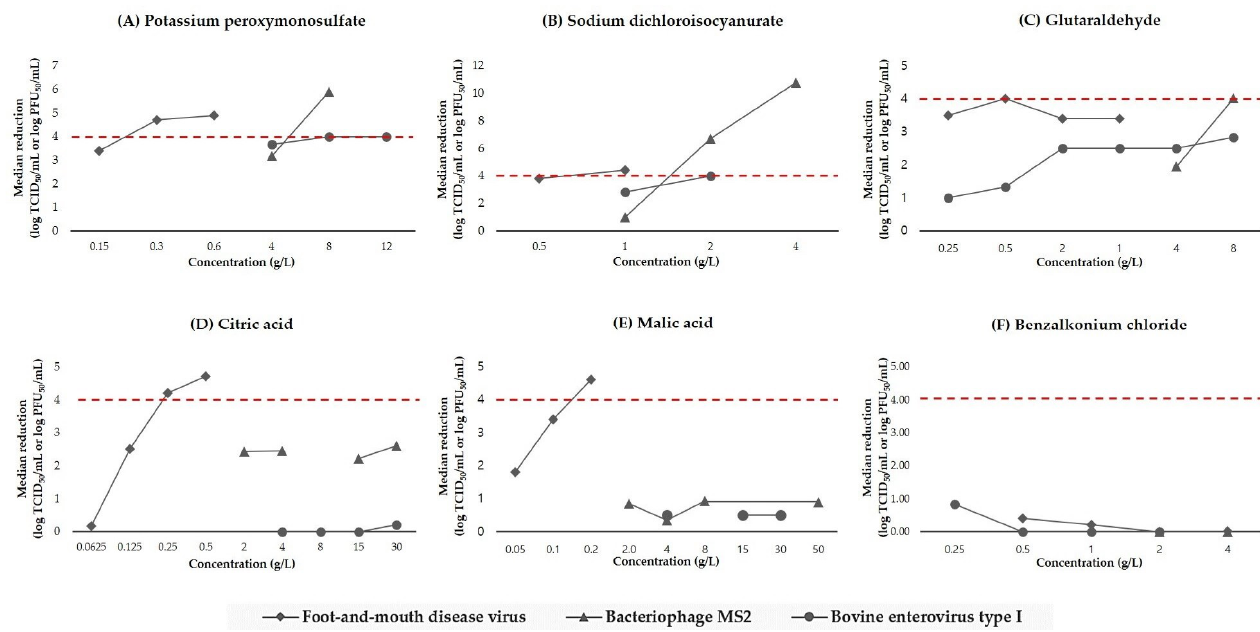
Figure 1. Comparison of the median reduction titer (in log TCID 50 /mL or PFU/mL) at concentra- tions of the active substances against foot-and-mouth disease virus (square solid line), bacteriophage MS2 (triangle solid line), and bovine enterovirus type 1 (circle solid line). ( A ) Potassium peroxy- monosulfate. ( B ) Sodium dichloroisocyanurate. ( C ) Glutaraldehyde. ( D ) Citric acid. ( E ) Malic acid. ( F ) Benzalkonium chloride. The red dashed line indicates virucidal effect